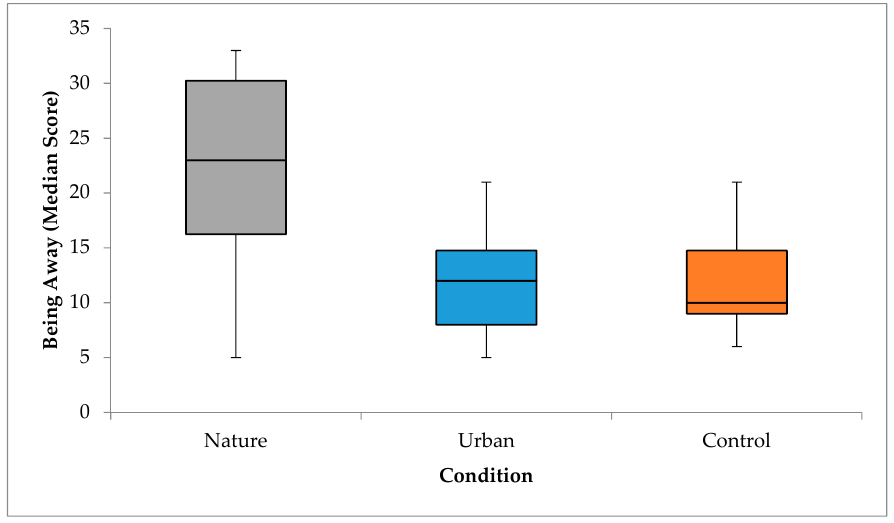
Figure 7. Differences in being away between conditions at post-manipulation.